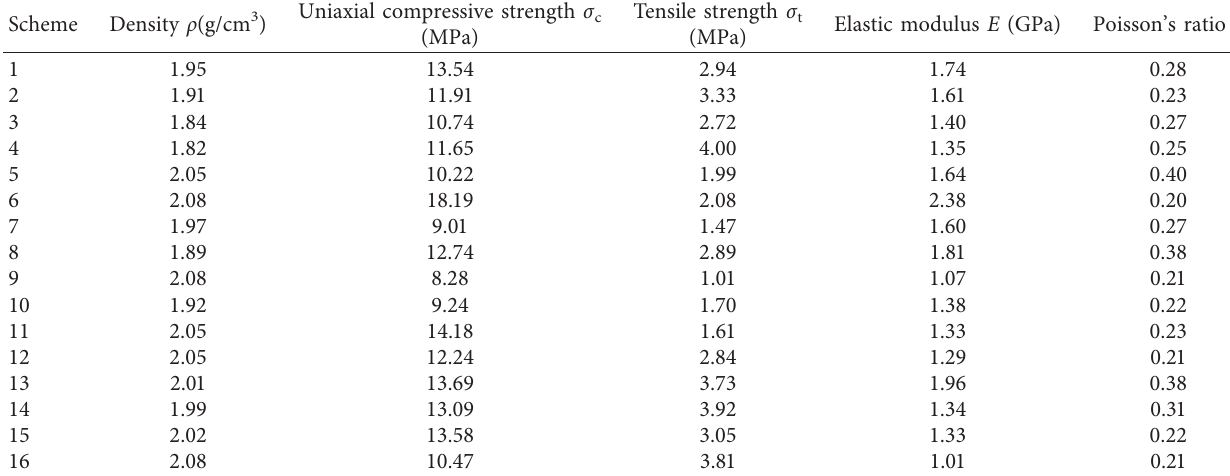
Table 7: Physical and mechanical properties of similar materials.